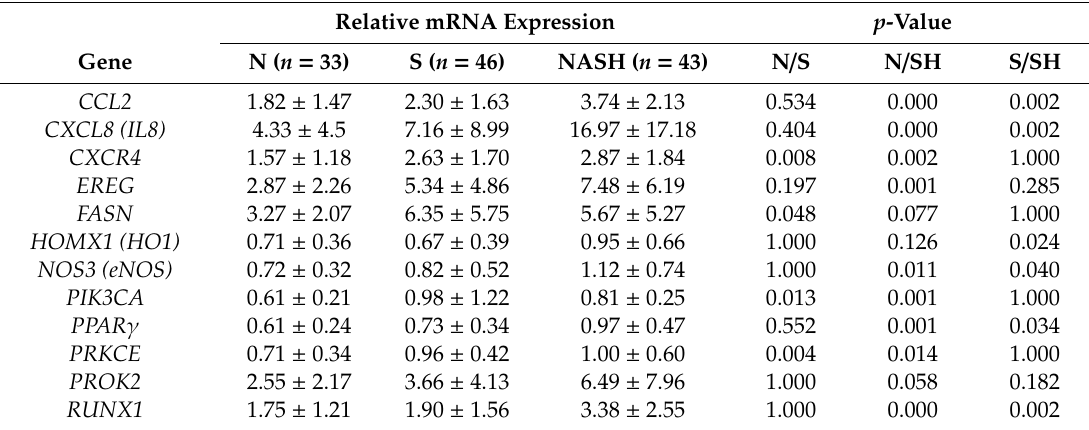
Table 1. Analysis of mRNA expression of genes associated with angiogenesis in resected hepatic tissue samples of patients with normal liver (N), steatosis (S) and non-alcoholic steatohepatitis (NASH). Data are shown as means ± SD and statistical di ff erences were analyzed by pairwise comparison using a Kruskal–Wallis